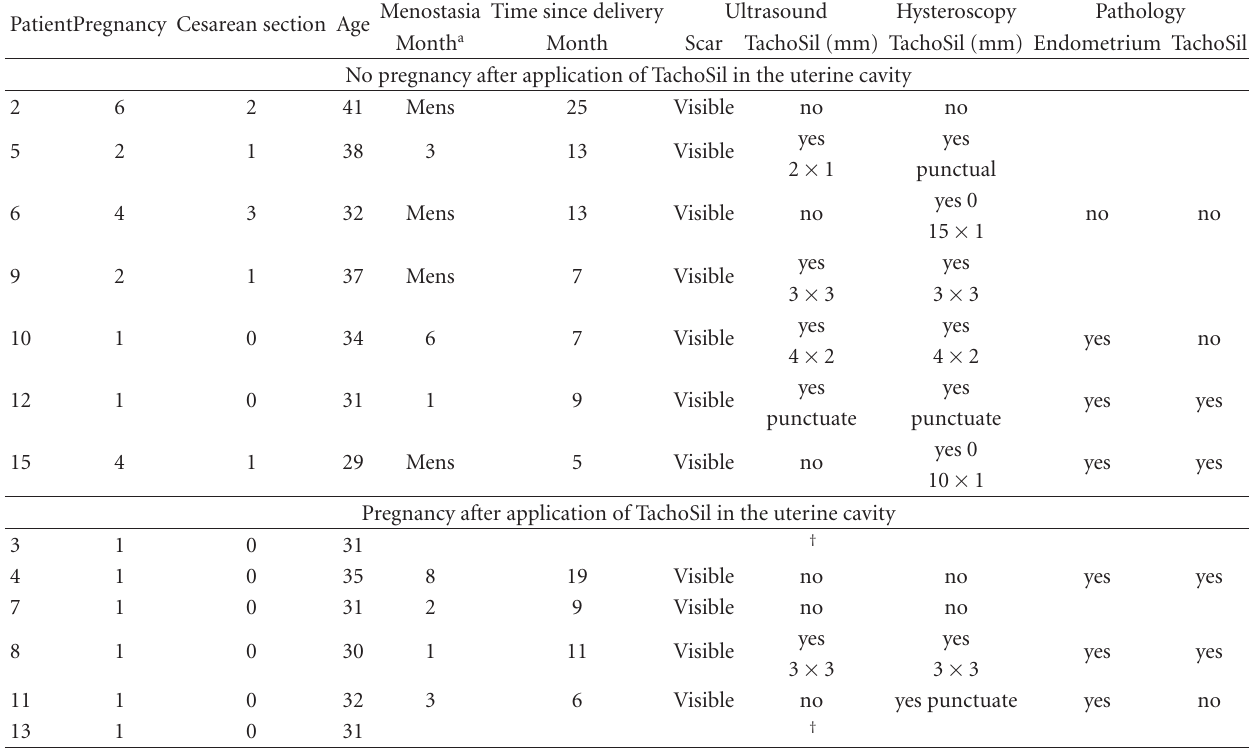
Table 1: Results of clinical control and overview of pregnancies after treatment with TachoSil application in the uterine cavity. Menostasia Time since delivery PatientPregnancy Cesarean section Age